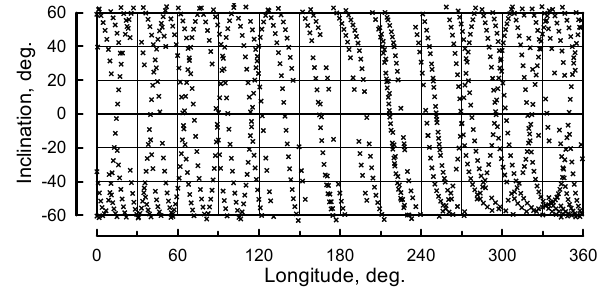
Fig. 1. The example of data coverage for the maps for 01:00– 03:00 LT of the June solstice.